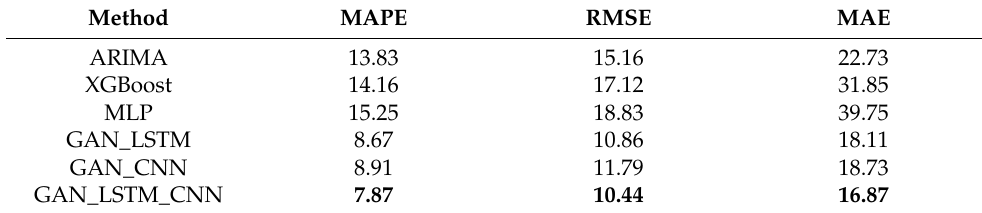
Table 6. Performance Comparison Wuhan railway Station Area.